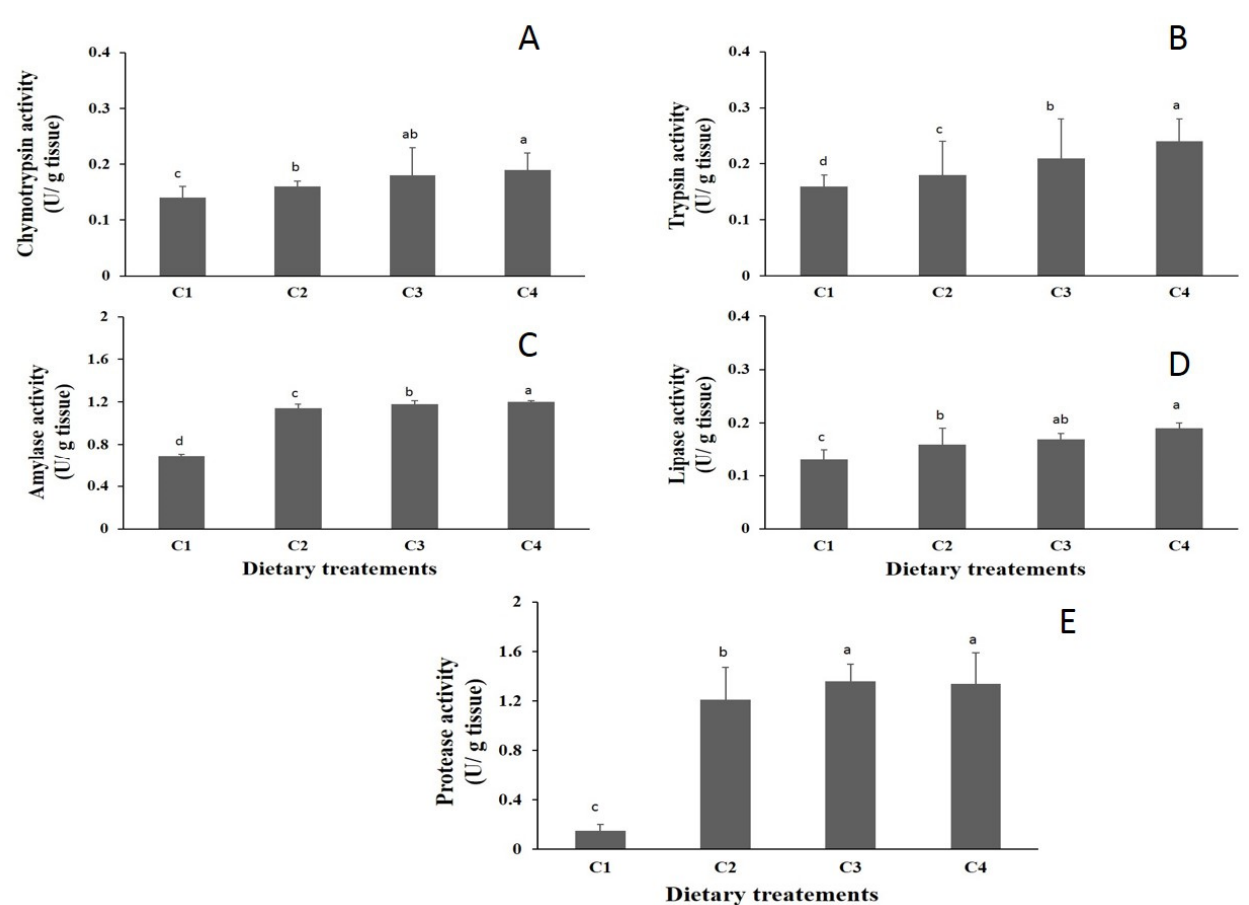
Figure 1. Digestive enzymes analysis of the intestine (( A ), chymotrypsin; ( B ), trypsin; ( C ), amylase; ( D ), lipase; ( E ), protease (U/g tissue)) of Pacific white shrimp, Litopenaeus vannamei , fed various concentrations of β -1,3 glucan and Fructooligosaccharides for 75 days. Data are presented as means ± SD ( n = 3). Superscripted letters denote significant differences between experimental groups (ANOVA; p < 0.05).